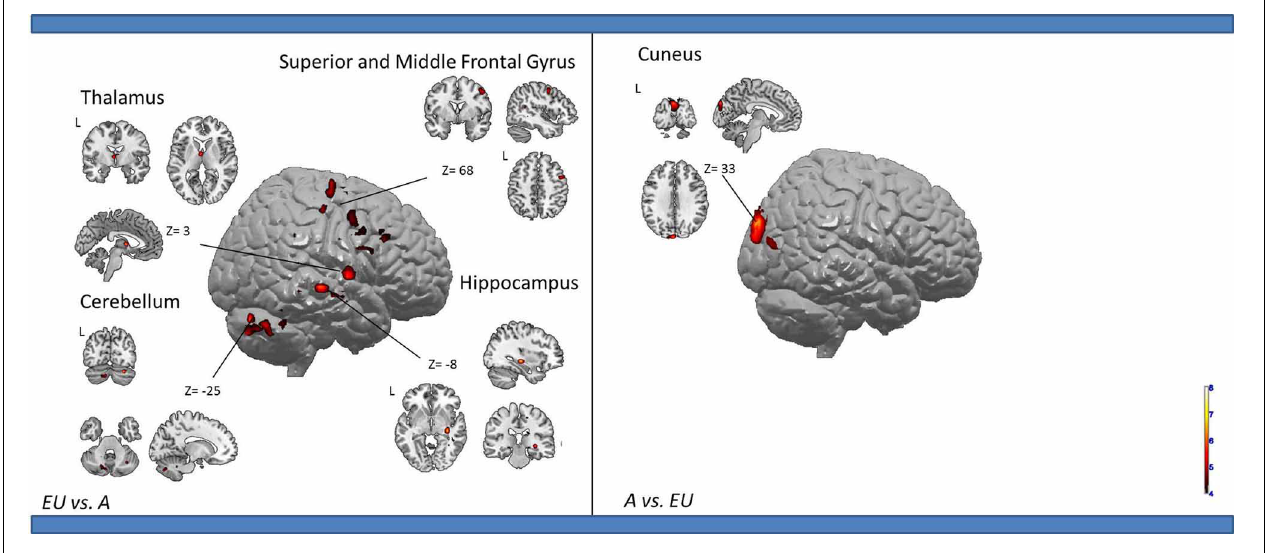
FIGURE 2 | Shows regions reported in Table 3 projected onto 3D anatomical template (random-effect analysis, statistical threshold: uncorrected p < 0 . 001, cluster extent: k ≥ 10 voxels). Activations are provided by a random effect analysis, for (1) EU spatial encoding when